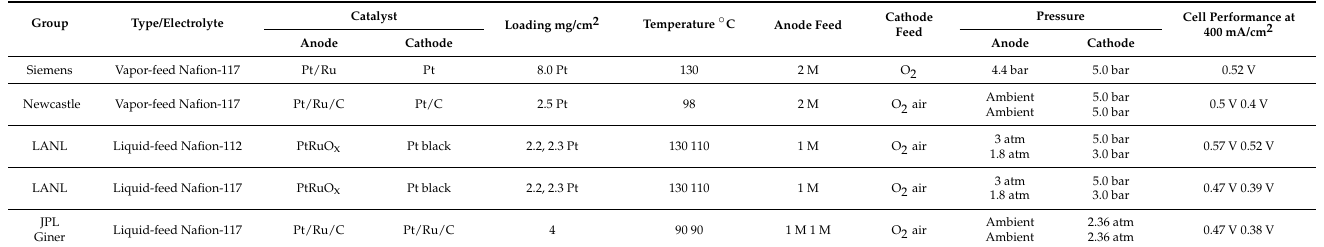
Table 3. DMFC compositions and operating conditions of various groups